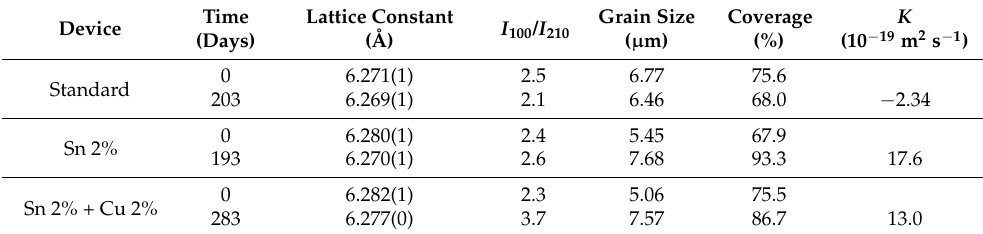
Table 6. Structural parameters of the present perovskite crystals. I 100 / I 210 : ratios of (100)